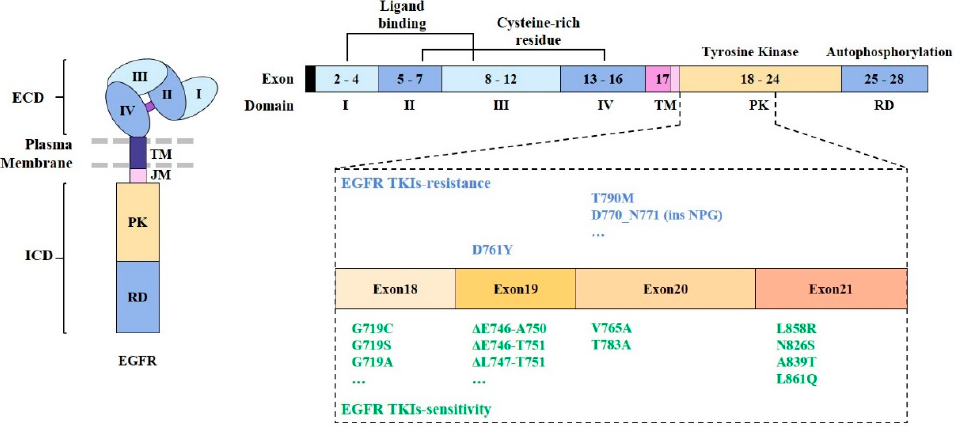
Figure 2. Domains of EGFR and the sites of mutations. Mutations that are associated with sensitivity or resistance to EGFR-TKIs are denoted. Specific mutations in the kinase domain of EGFR are shown. TKI denotes tyrosine kinase inhibitor.